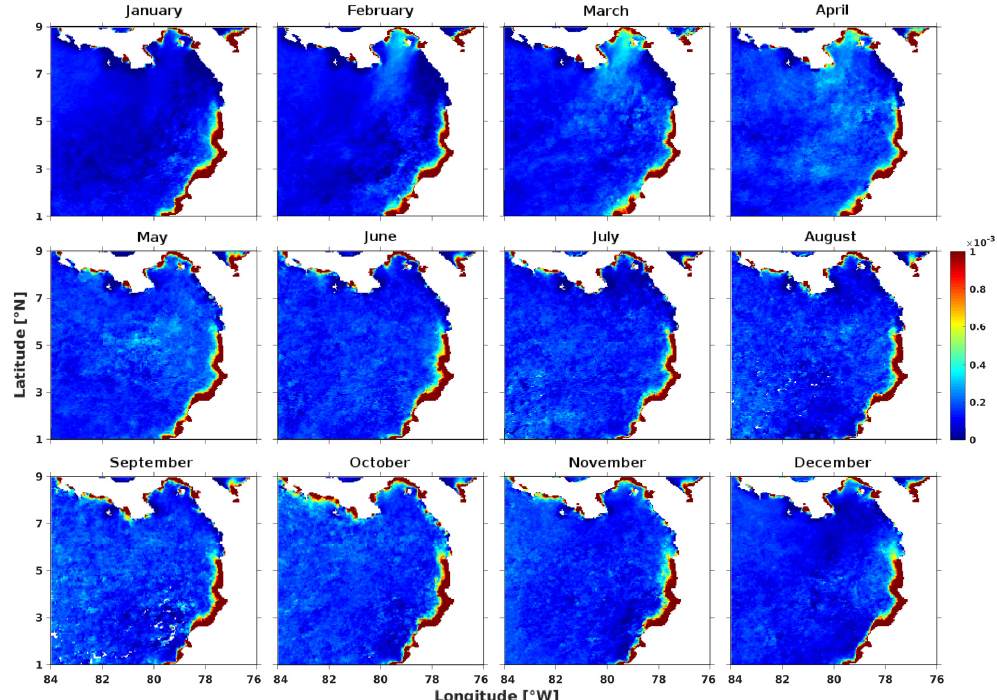
Figure A1. Monthly mean climatology of remote sensing reflectance at 645 nm (Rrs645; sr -1 ) as a proxy for turbid plumes from river discharges in the Panama Bight for the period of January 2002 to December 2016. Higher turbidity levels are represented by red color. Remote Sens. 2020 , 12 , x FOR PEER REVIEW